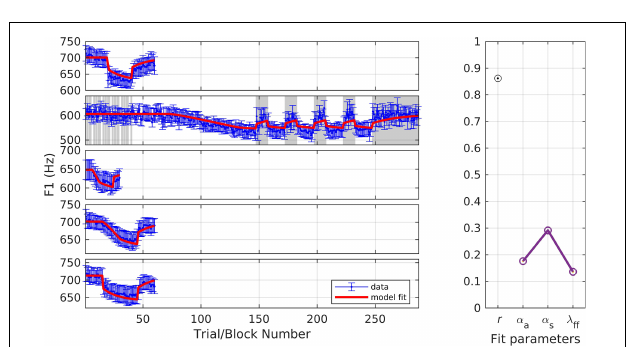
FIGURE 12 | Simulation 10: model fits across all included F1 adaptation studies. From top to bottom: data from Haenchen (2017), Ballard et al. (2018), Daliri et al. (2018), and Chao and Daliri (gradual and sudden conditions; unpublished data). Noise masked trials indicated with gray shading. (Left) Mean and standard error of experimental data in blue; model fit in red. (Right) Fit quality and optimized parameter values ( r = correlation coefficient; α A = auditory feedback control gain, α s = somatosensory feedback control gain, and λ FF = learning rate).